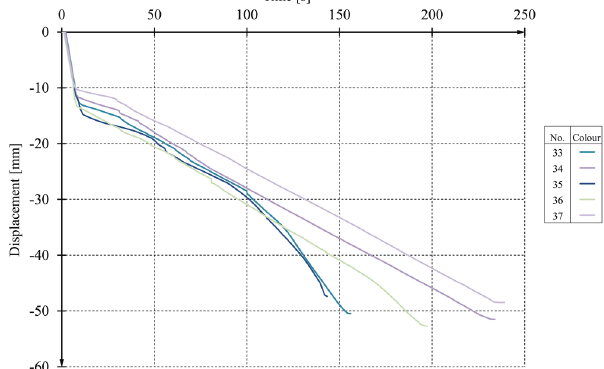
Fig. 6b. Changes of displacements of piles heads in brick specimens